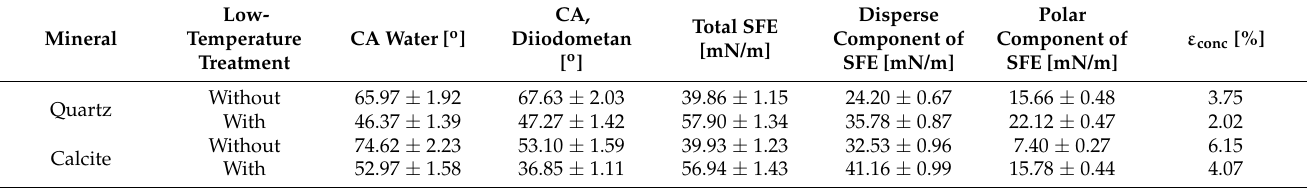
Table 9. Results of research on the effect of low-temperature treatment on the technological properties of quartz and